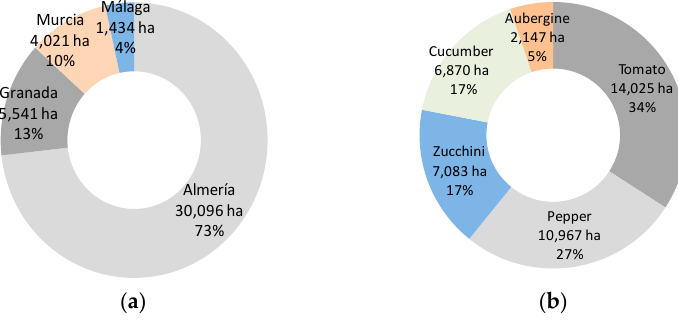
Figure 9. Distribution of area of greenhouses (hectares) in southeast Spain. ( a ) Percentage distribution by province; and ( b ) Percentage distribution by crop.